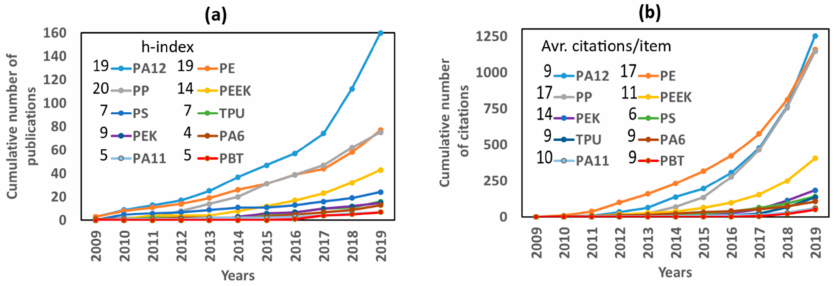
Figure 1. Bibliometrics on L-PBF of PA12, PA11, PA6, PP, PEEK, TPU, PEK, PS, PE, and PBT powder feedstocks processed by L-PBF over the last decade: ( a ) cumulative number of publications and corresponding h-index; ( b ) the cumulative number of citations and average citations per